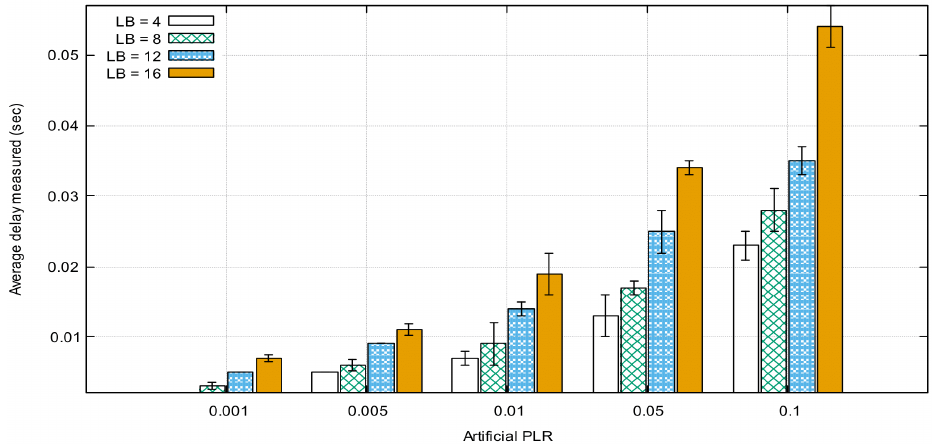
Figure 7. Average delay of retransmitted packets.